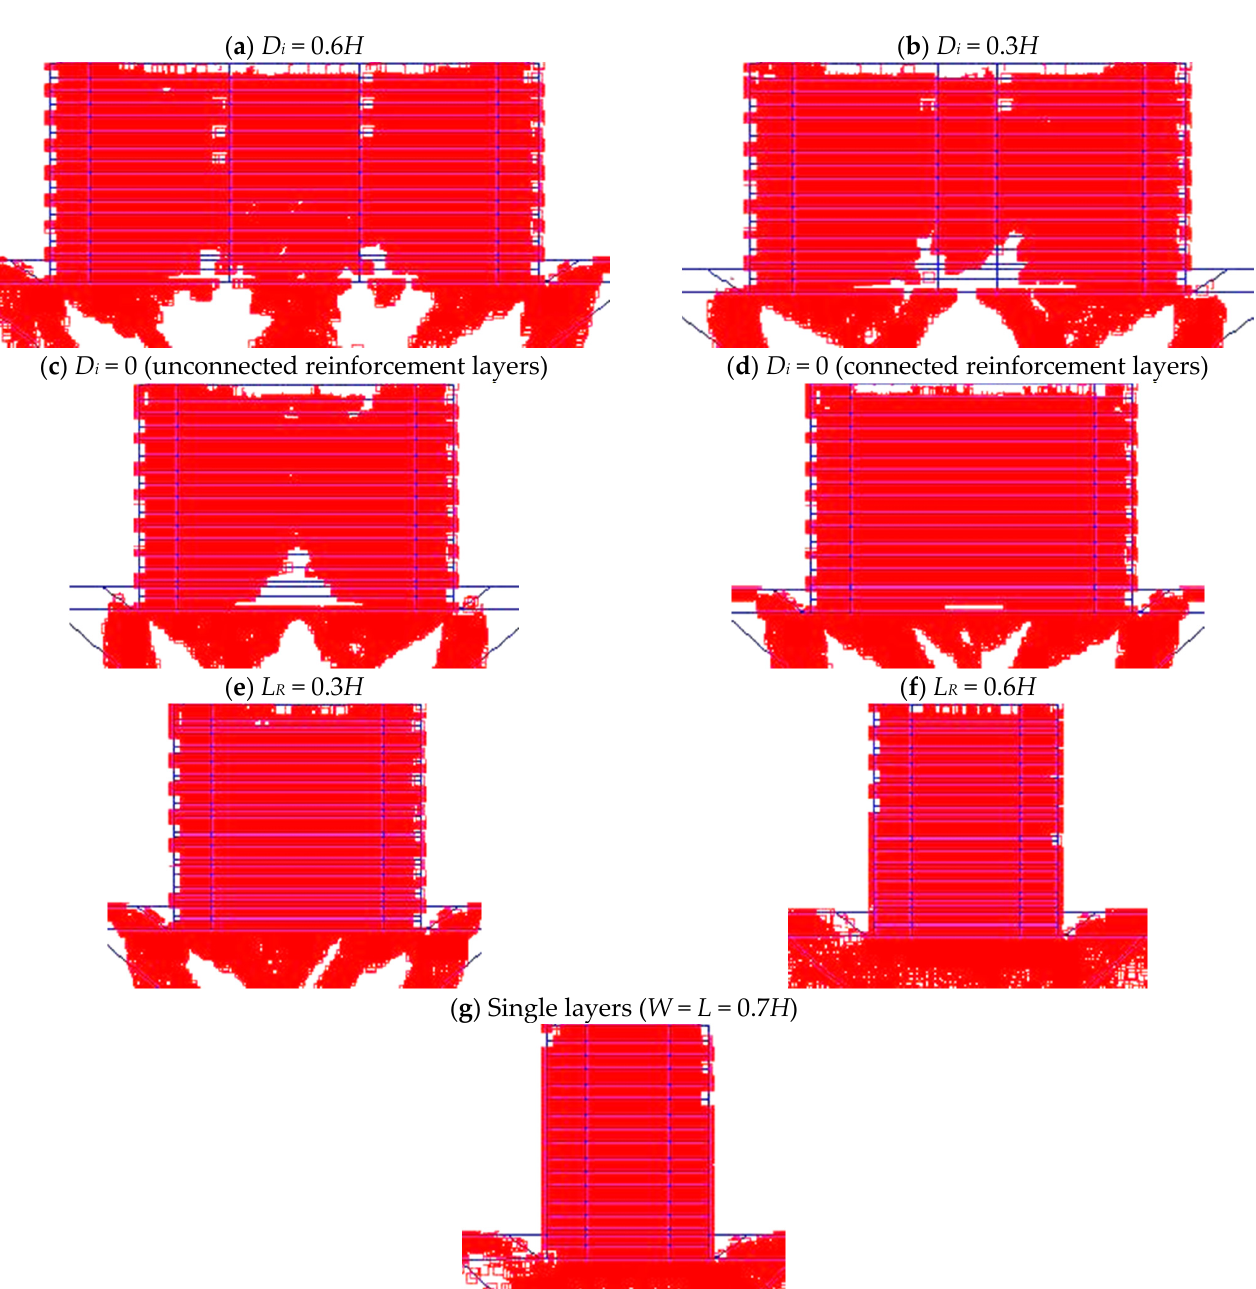
Figure 11. Plastic zones (Mohr–Coulomb points) in the soil at failure with the c - ϕ reduction method at end of construction (EoC) for walls with different interaction distance ( D i ) between the back of the reinforced soil zones for opposite walls. (Note: white zones on top of the models represent the location of tension cut-off points).